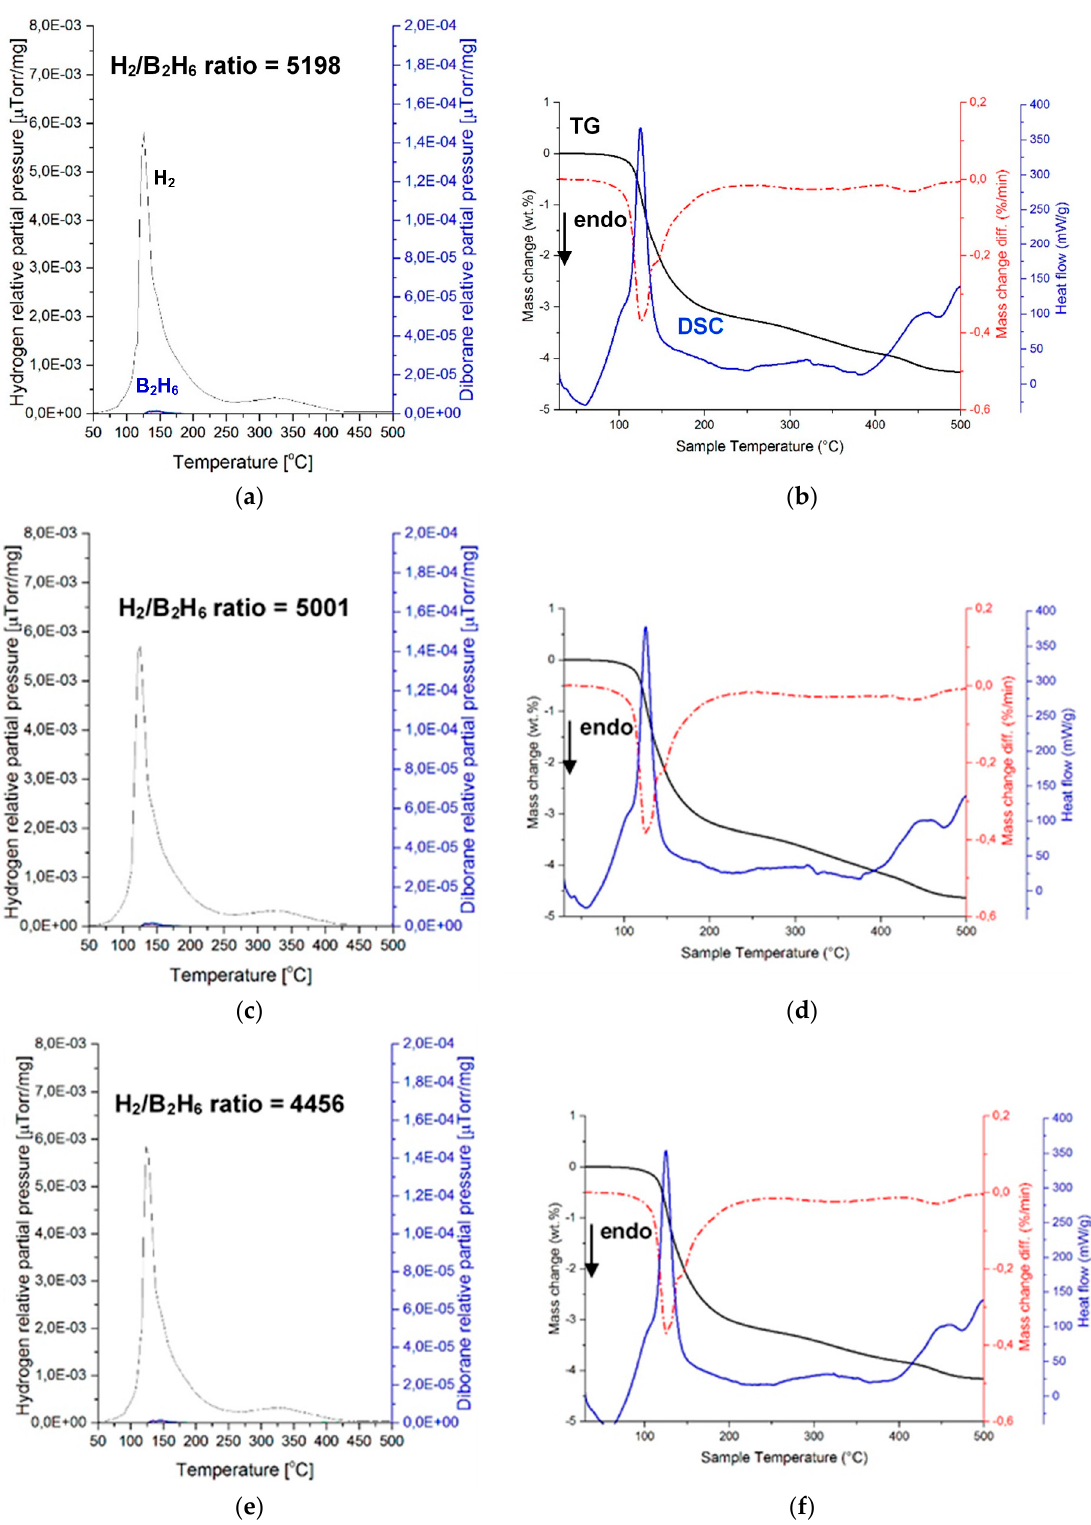
Figure 6. Mass spectrometry (MS) (gas desorption spectra) of a (H 2 + B 2 H 6 ) mixture, and the TGA and DSC curves during gas desorption for a ((2NaBH 4 + MnCl 2 ) + 5 wt. % LiNH 2 ) sample, BM for 0.5 h (Q TR = 36.4 kJ/g). Heating rate 5 °C/min. ( a , b ) sample 1, ( c , d ) sample 2, and ( e , f ) sample 3.